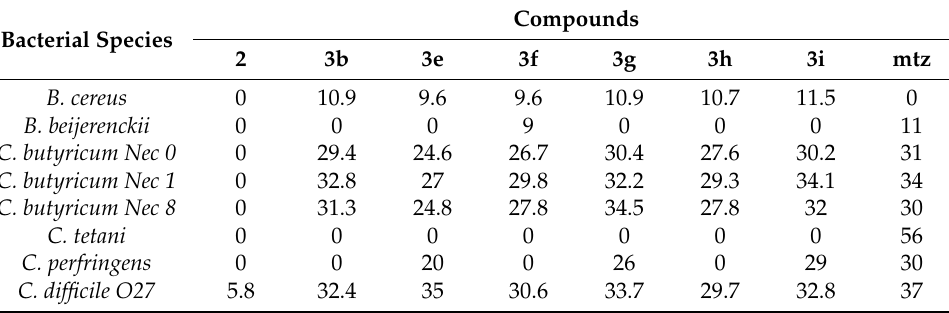
Table 9. Antibacterial activity of the most promising molecules.